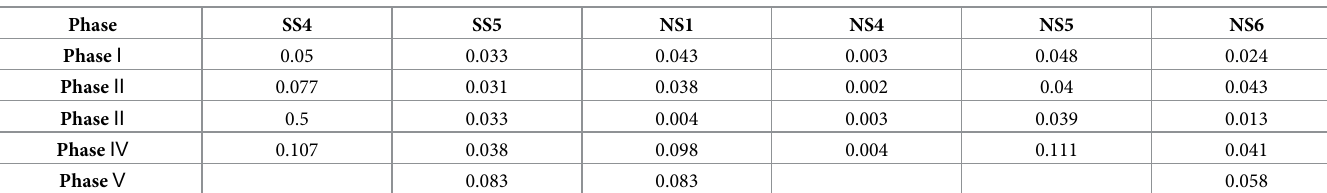
Table 6. Network density.